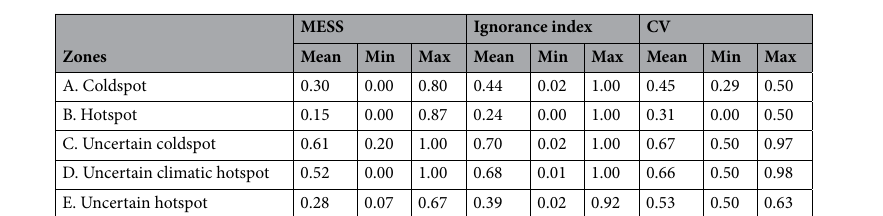
Table 4. Summary statistics of the different sources of uncertainty, associated with the environmental predictors ( MESS , Multivariate Environmental Similarity Surfaces, expressed as the proportion of species present in each grid-cell presenting dissimilar environments); the occurrence data ( Ignorance index , half- ignorance index per grid-cell calculated as in Supplementary Eq. S1; higher values indicate less occurrence data); and the variability of predictions (CV, average coefficient of variation per grid-cell over all-species ensemble predictions). Mean, minimum (Min) and maximum (Max) values per zone are reported.